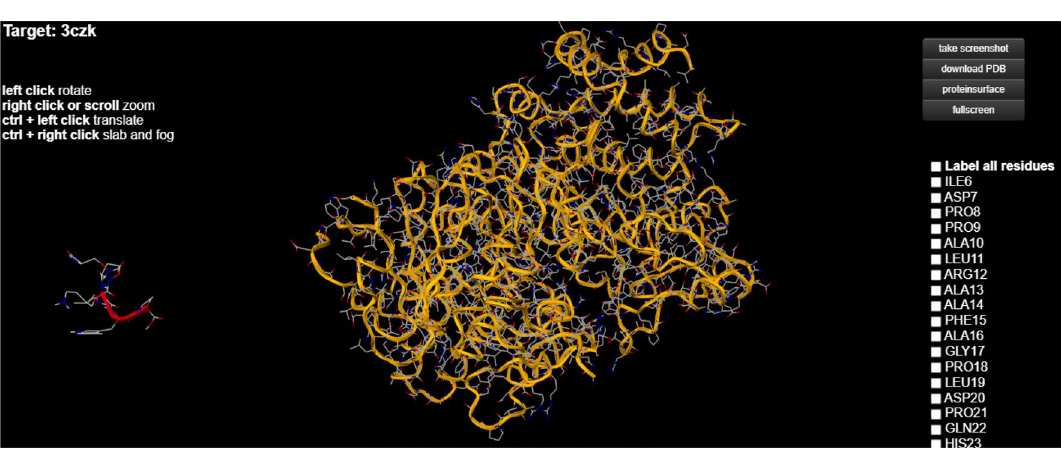
Figure 12. Structures of the two test molecules (C-reactive protein and sucrose) obtained using 1-CLICK DOCKING Software from the mcule platform, version from 2011, https:// mcule. com/ apps/1- click- docki